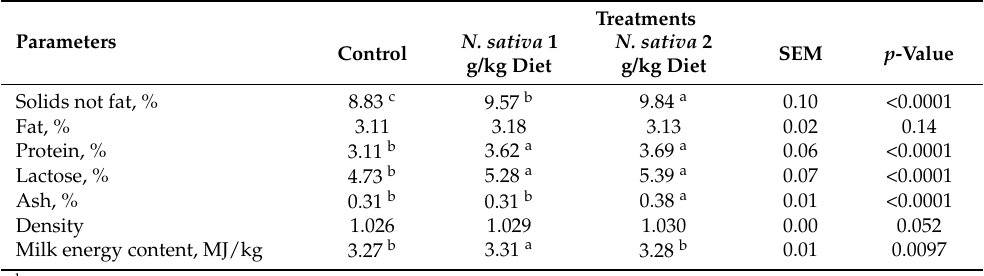
Table 3. Effects of N. sativa (10.0 and 20 g/kg diet) on milk constituents of Ardi goats in